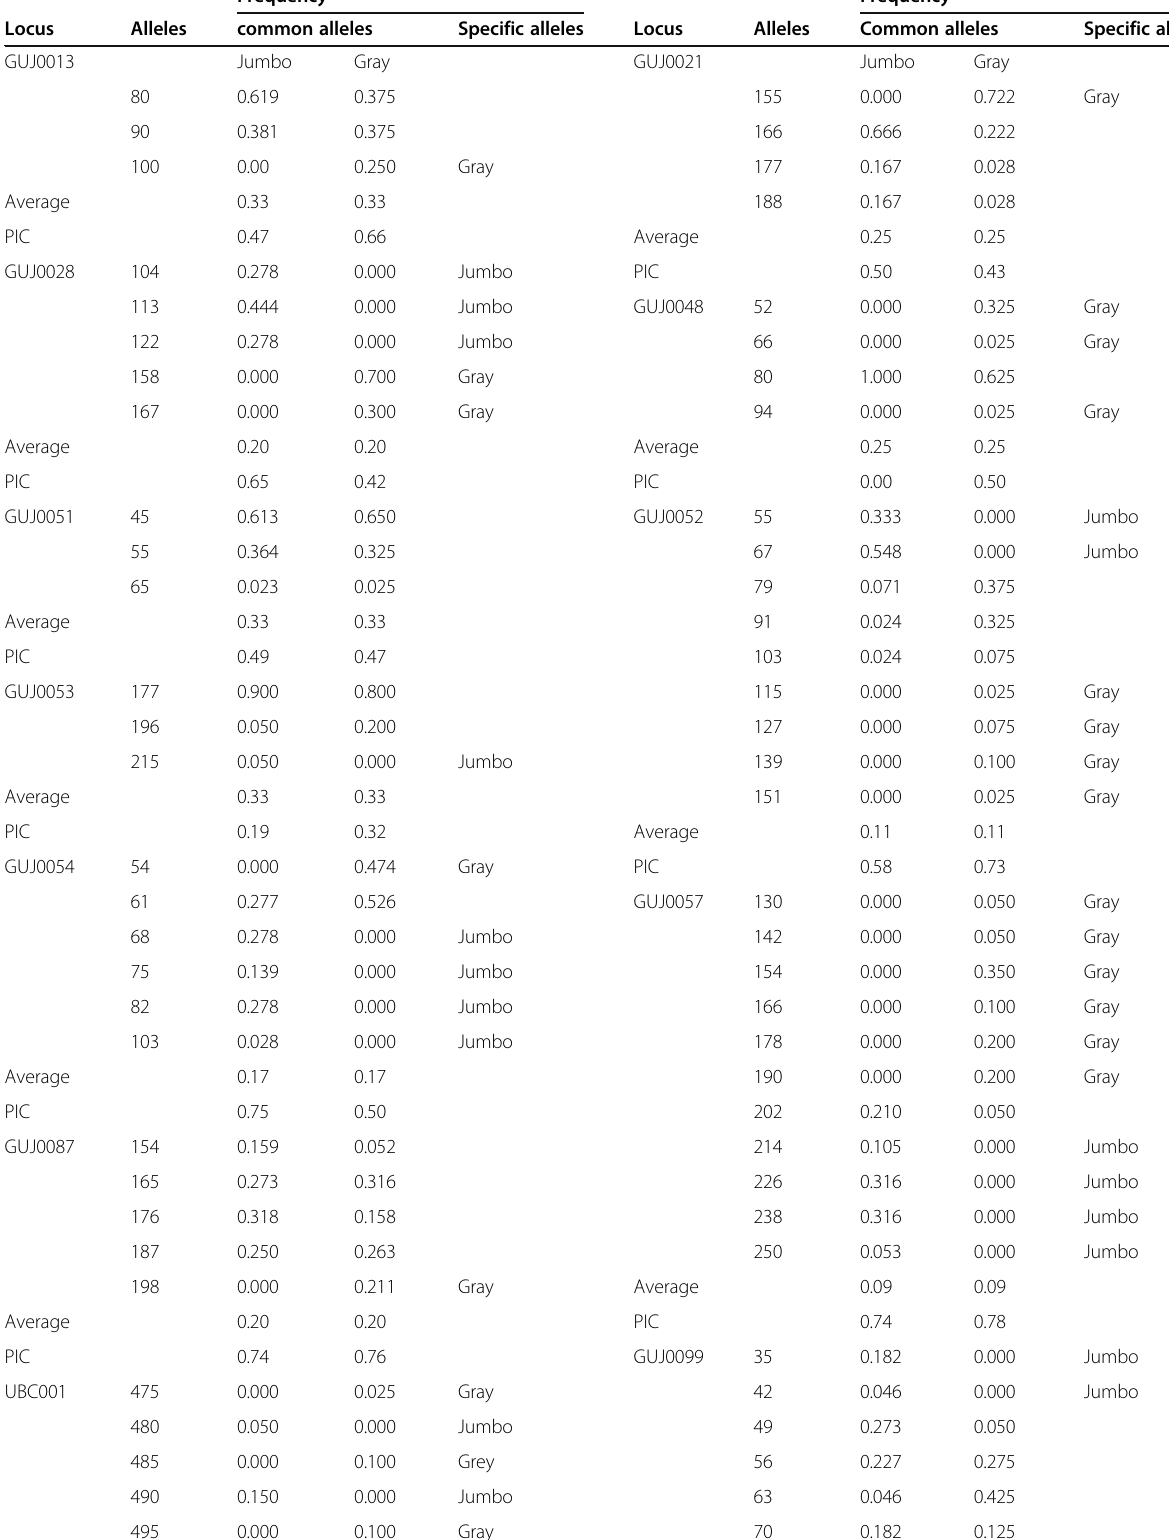
Table 6 Specific alleles in base pairs and frequencies observed for jumbo and gray Japanese quail